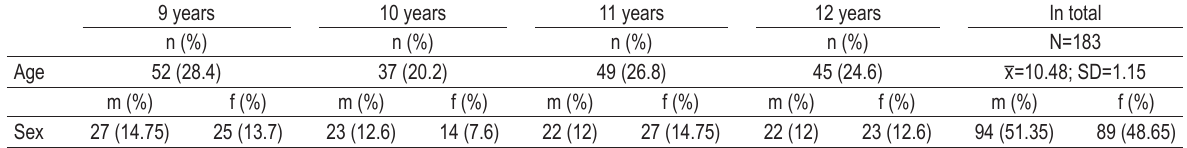
TABLE 3. Descriptive characteristics of the retest group